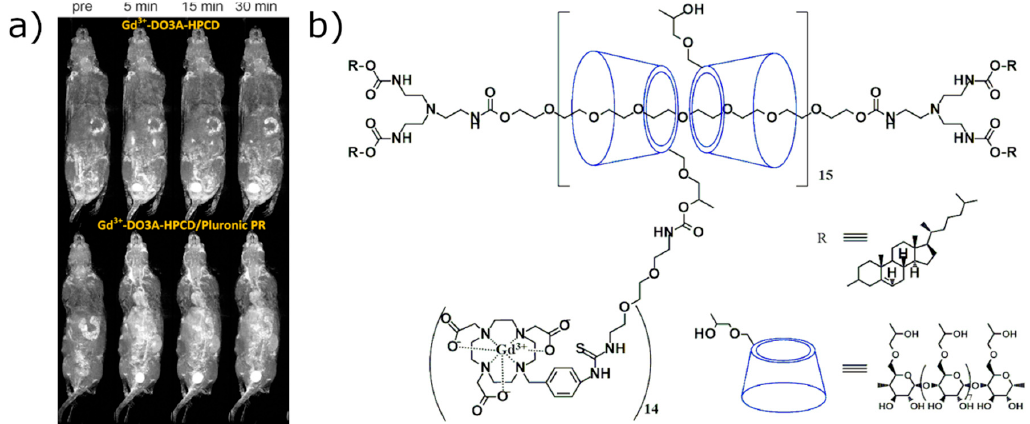
Figure 6. ( a ) T1 weighted 3D maximum intensity projection images of Balb/c mice. Mice were injected with Gd(III)-DO3A-HPCD (top row) or Gd(III) -DO3A-HPCD/Pluronic polirotaxane (bottom row) at a 0.03 mM-Gd/kg dose. Contrast agent distribution is shown in the images for pre injection and 5, 15, and 30 min after injection in to the tail vein with Gd3+ complexes. Images have been re-printed with permission from publisher [73]. ( b ) Molecular structure of the Gd(III)-DO3A-HPCD/Pluronic polirotaxane developed by Zhou et al.